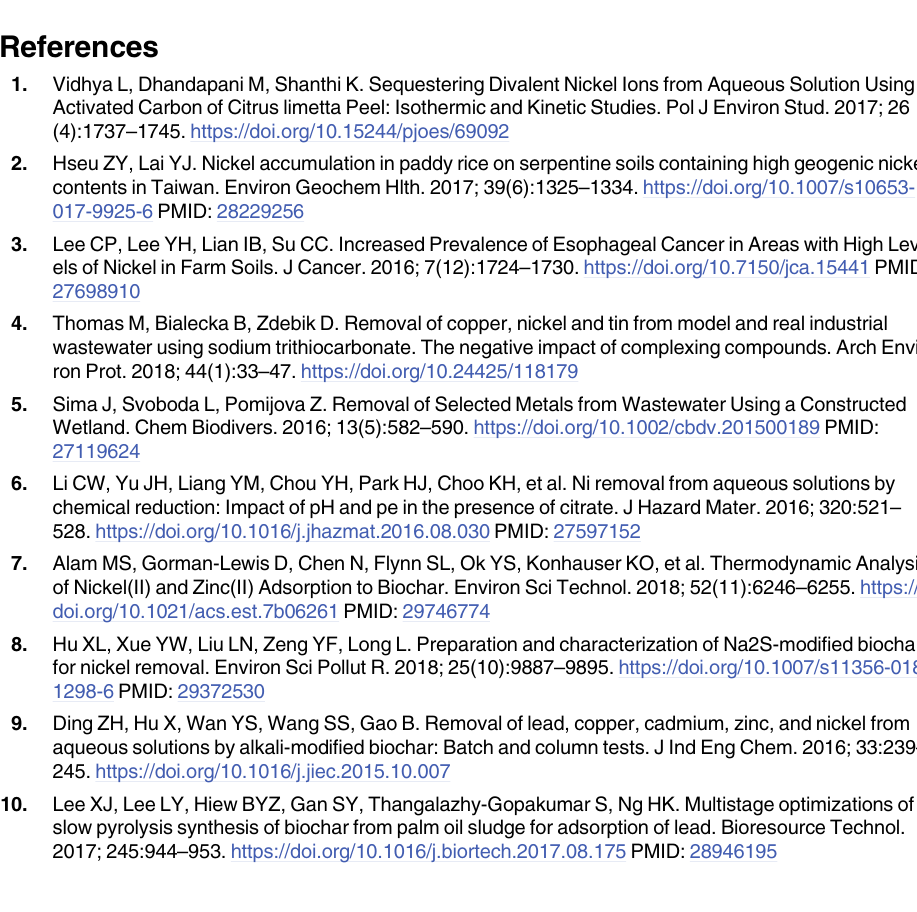
S3 Fig. FTIR spectra of SBC and MSBC before nickel adsorption. (TIF) S4 Fig. FTIR spectra of MSBC before and after nickel adsorption. (TIF) S5 Fig. XRD spectra of MSBC after nickel adsorption. (TIF) S1 Data. Raw Data.